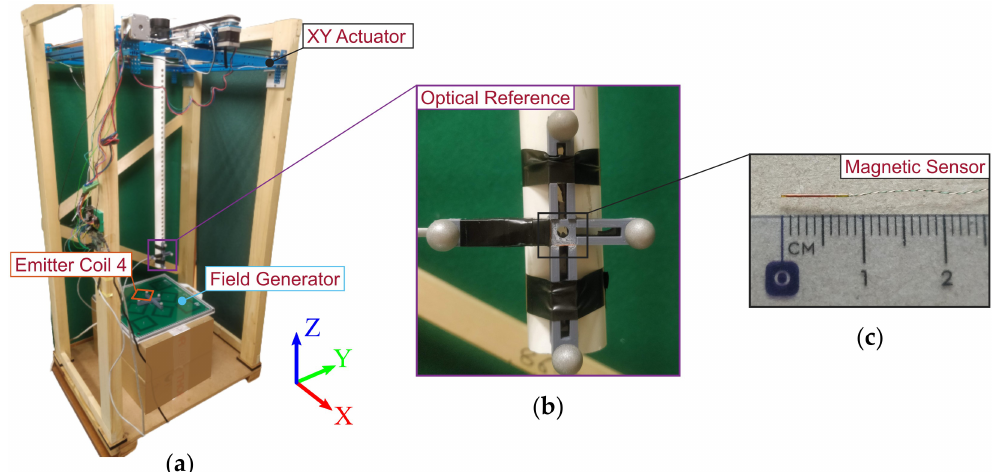
Figure 3. ( a ) A motorised actuator was used to move the surgical sensor on an XY plane. Optical tracking provided precise pose reference. One of the eight emitter coils of the field generator is highlighted in orange. ( b ) Two sensors were embedded in the dynamic reference frame to quickly collect data in different directions. ( c ) Miniature sensor coil used in the experiment.